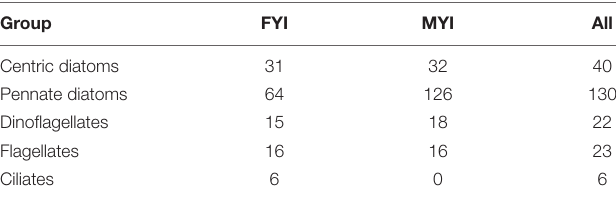
TABLE 2 | Number of species within sea-ice protist groups for first-year ice (FYI), multiyear ice (MYI) and all samples (All).